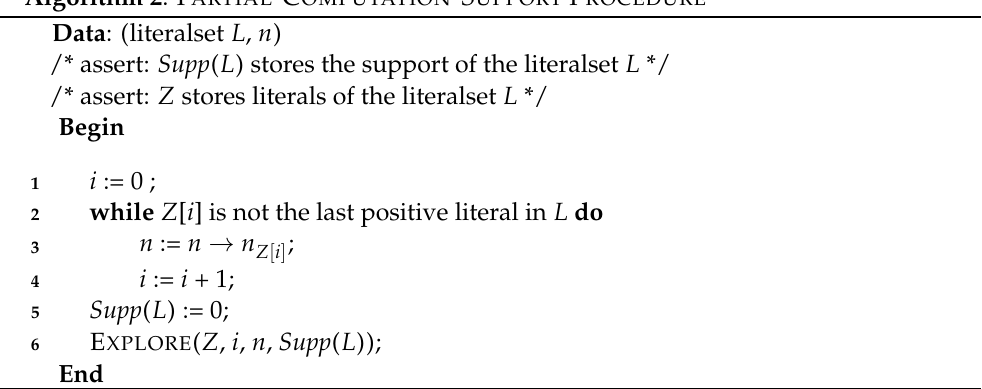
Algorithm 2 : P ARTIAL -C OMPUTATION -S UPPORT P